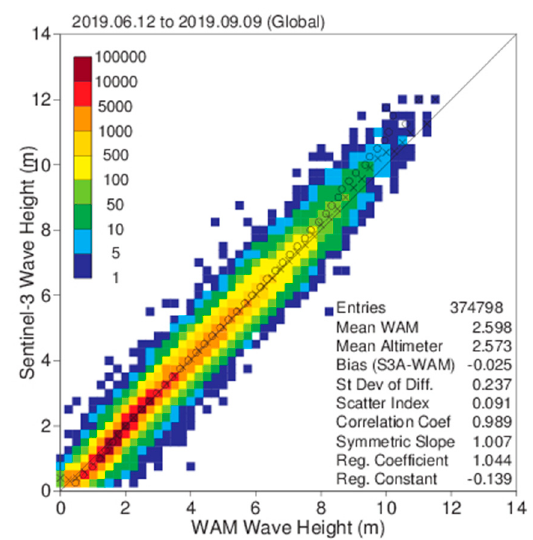
Figure 1. Comparison between Sentinel 3A significant wave height and the European Centre for Medium-Range Weather Forecasts (ECMWF) wave model results.